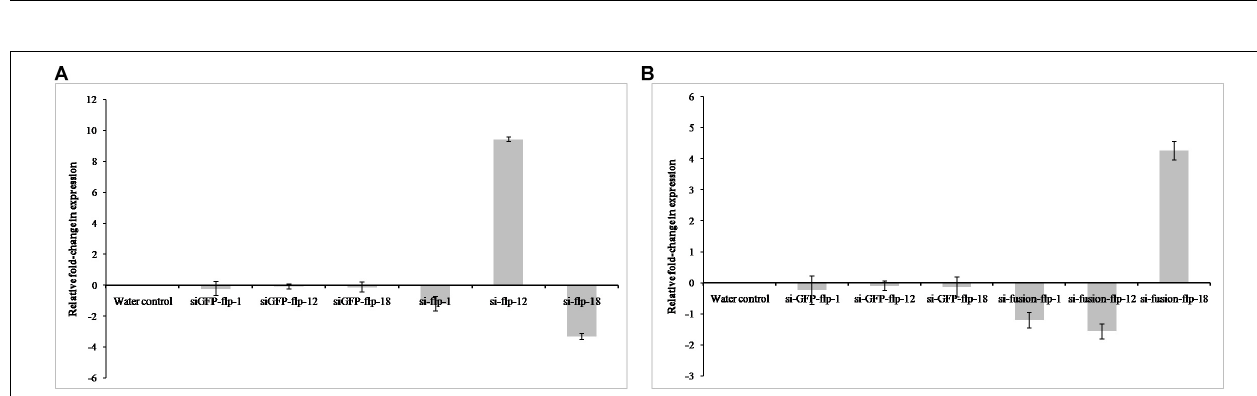
Frontiers in Microbiology |